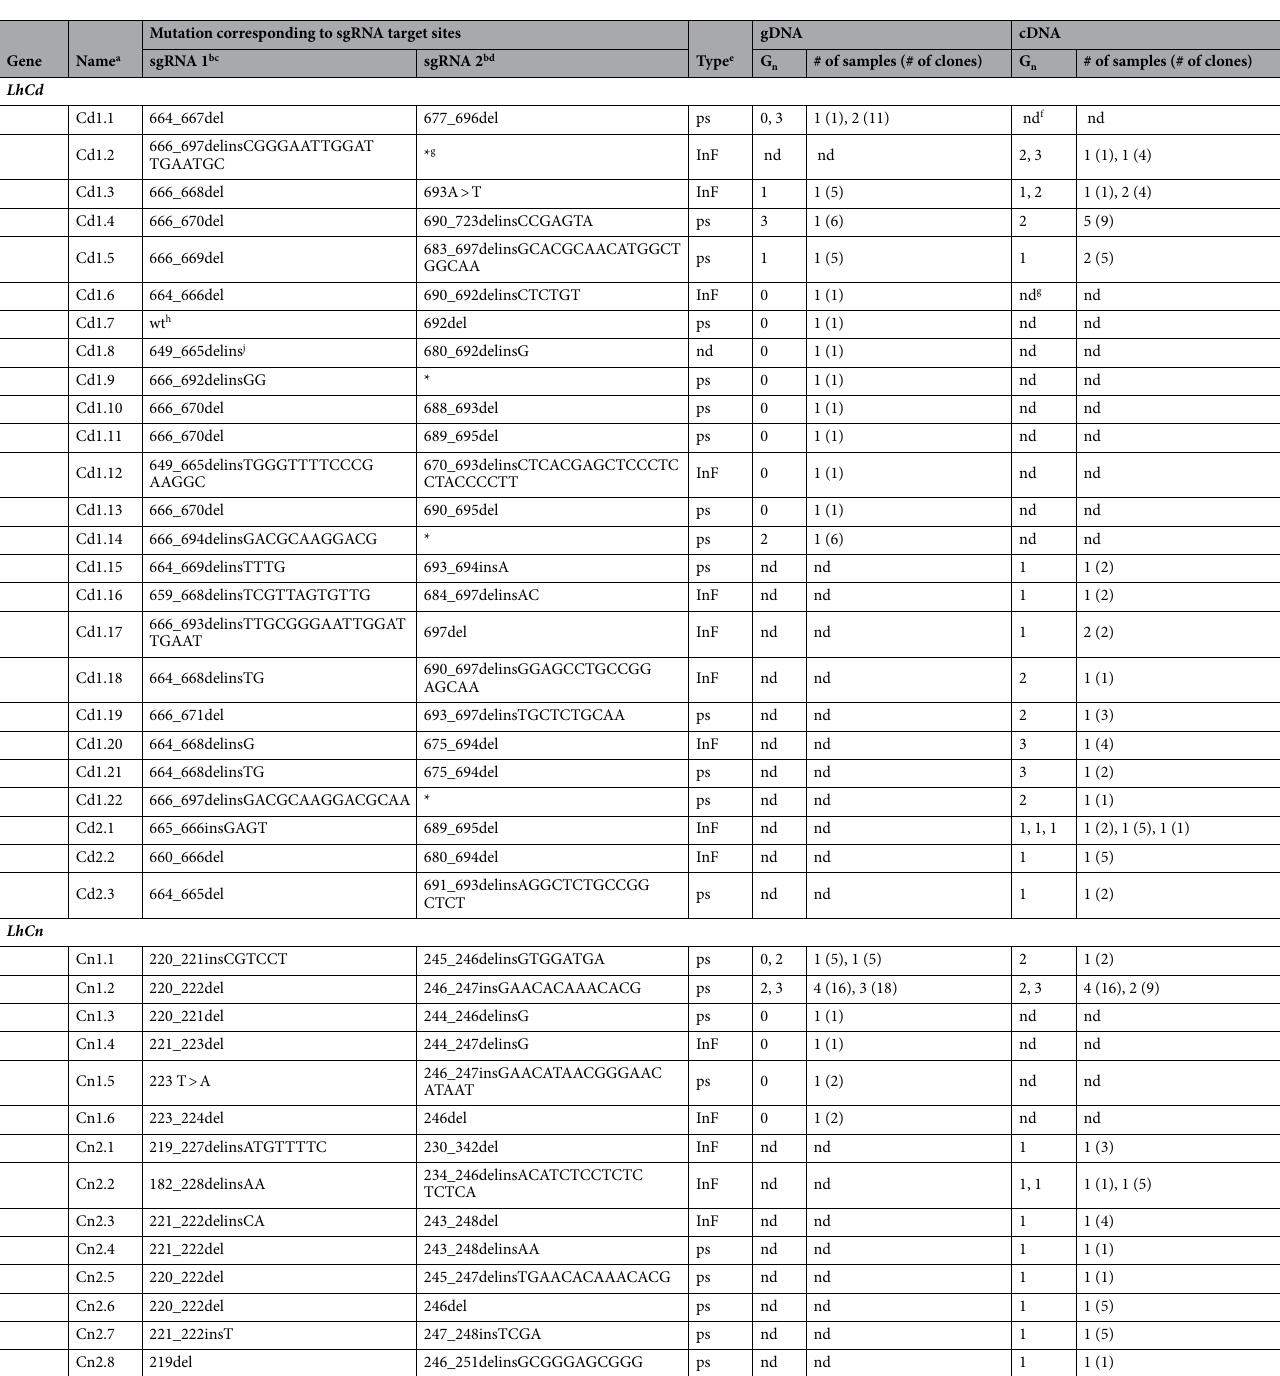
Table 1. CRISPR/Cas9 induced LhCd and LhCn mutations in Lygus hesperus . a Mutation name defines the combination of alleles at sgRNA1 and sgRNA2 target sites in an individual as a single mutation. b Mutation nomenclature, showing the nucleic acid sequence changes in LhCd and LhCn , are based on the recommendations by the Human Genome Variation Society (http:// www. hgvs. org/), with modification to omit the “prefix.” Mutations within 10 nucleotides were considered one mutation event. c Mutations for sgRNA1 corresponding to either LhCd or LhCn. d Mutations for sgRNA2 corresponding to either LhCd or LhCn. e Type of mutation (ps, premature stop; InF, in-frame mutation, nd, mutation type cannot be determined because the putative splice site was affected). f nd = not determined. *g Mutation corresponding to sgRNA 1 that also spans the sgRNA 2 target site. h wt = wild-type allele. i Sequence corresponding to the delins was too long for the respective table column: 649_665delinsTAA ATT GTA CAA TTT ATT GGC CAA CTA TTT CTA AAG ACG GTT ATC ATG ACA TAA ATA CCT AAT TTG GGG TTT TTG TCT GTG GGA TAT GCC TTA CAG ACT GAA AAT CTA TTG TTC CAT TTC TCT TCT